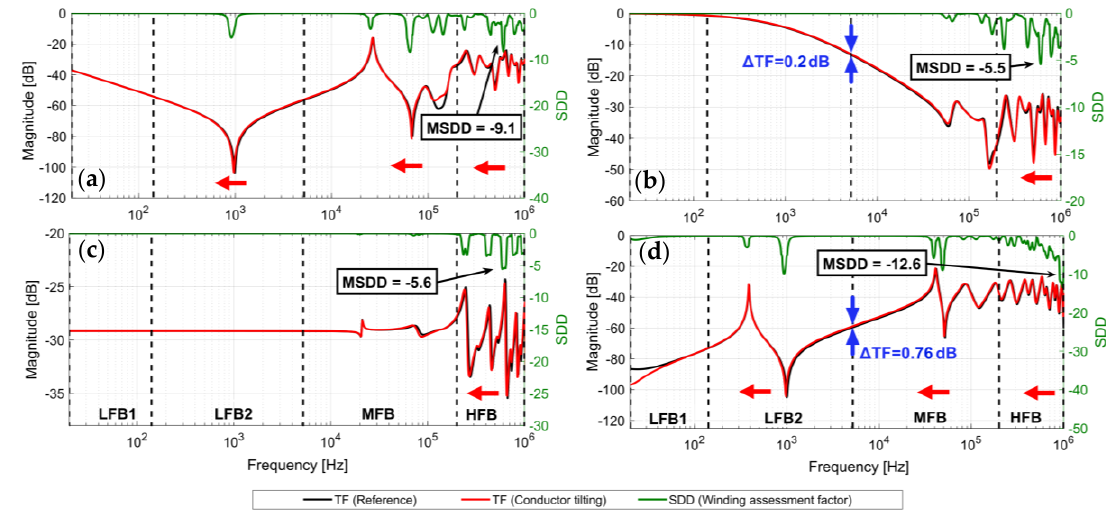
Figure 21. TFs of healthy and deformed (conductor tilting failure) B-phase HV winding (vector group YNyn0) and SDD as a measure of deviation between TFs; ( a ) HV-OC, ( b ) HV-SC, ( c ) IIW, ( d ) CIW.